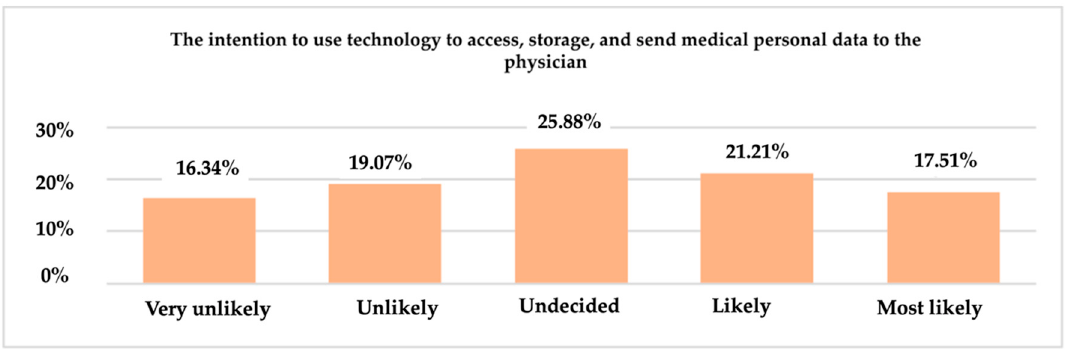
Figure 16. The intention of using technology—access, storage, and transfer of personal health data to a doctor.